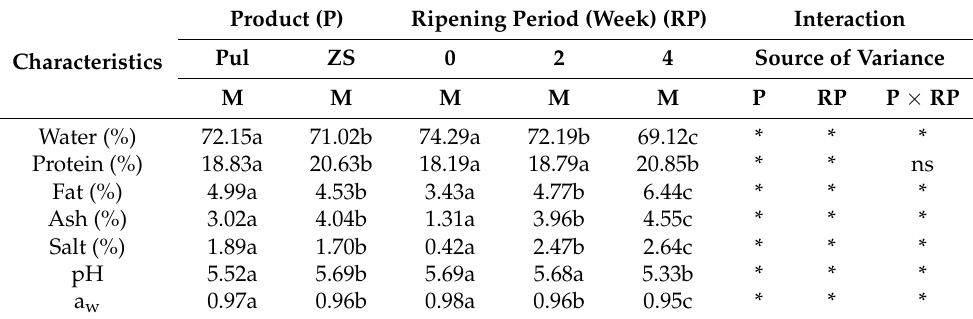
Table 1. The least-squares means from two-factor analysis of variance of the basic chemical composi- tion and physicochemical characteristics in relation to the type of dry-cured ham and the ripening